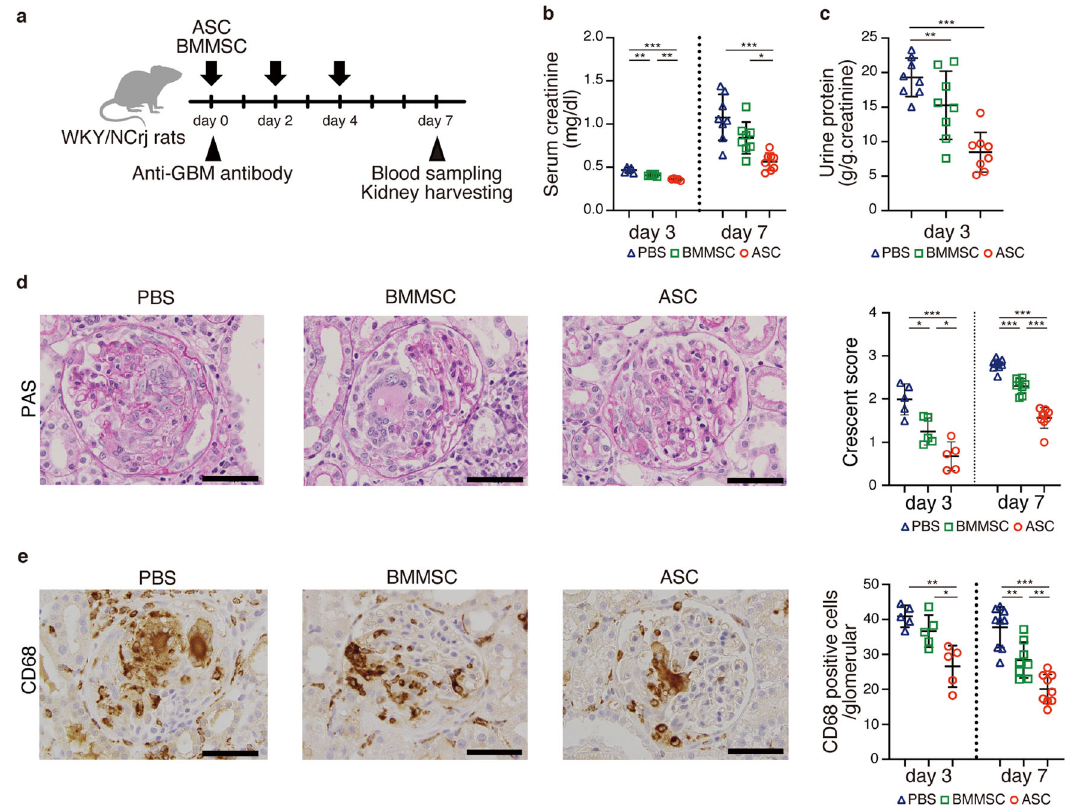
Fig. 1 Human ASCs showed greater therapeutic effects on rapidly progressive glomerular nephritis than human BMMSCs. a Experimental scheme depicting the induction of anti-GBM nephritis followed by intravenous ASC and BMMSC administration on days 0, 2, and 4. b Serum creatinine level on days 3 and 7 (day 3, n = 5 per group; day 7, n = 8 per group). c Urinary protein excretion on day 3 ( n = 8 per group). d Representative images of kidney sections stained with Periodic Acid-Schiff on day 7 (left) and glomerular injury scoring based on crescent formation on days 3 and 7 (right). e Representative images of kidney sections stained with anti-CD68 Ab on day 7 (left) and the number of CD68-positive cells in the glomerulus on days 3 and 7 (right). Scale bars, 50 μ m. (day 3, n = 5 per group; day 7, n = 8 – 9 per group). All data are shown as means ± SD. * p < 0.05, ** p < 0.01, *** p < 0.001, as determined by ANOVA. ASC adipose-derived MSC, BMMSC bone marrow-derived